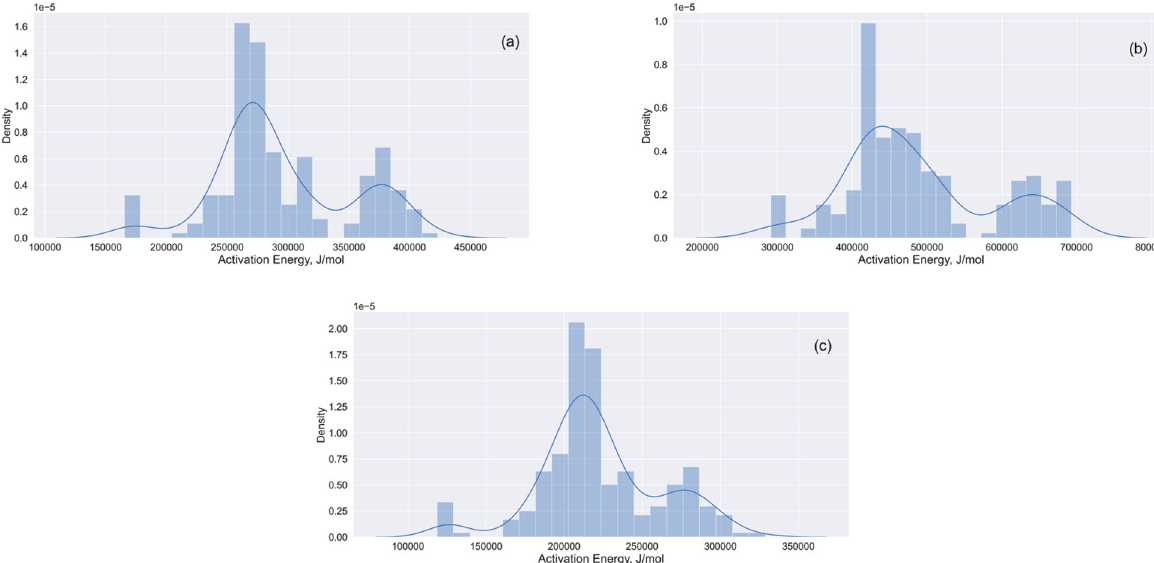
Fig. 2 Activation energies calculated with three different Arrhenius pre-factors. Activation energy distributions from the data set with different assumptions for the constant c which corresponds to the Arrhenius intercept. The distribution of activation energies is shown for the data when using the assumption of intercept ( a ) c = 0, ( b ) c = + 8, ( c ) c = − 3.